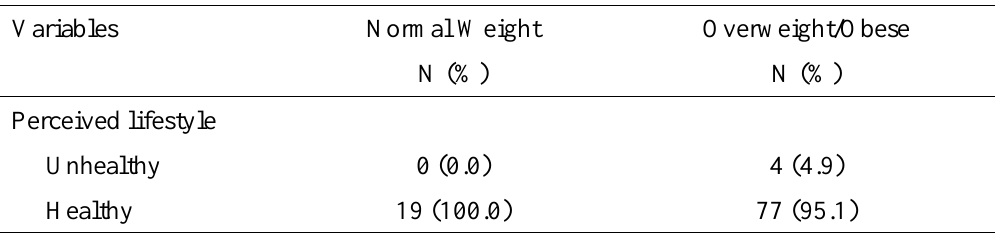
Table 2: Tabulation between perceived lifestyle and status of overweight and obesity in participants with Type 2